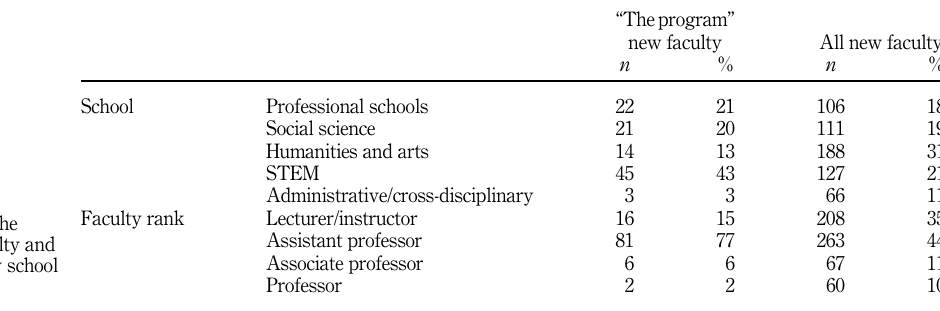
Table 1. Overview of “ the program ” faculty and new faculty by school and